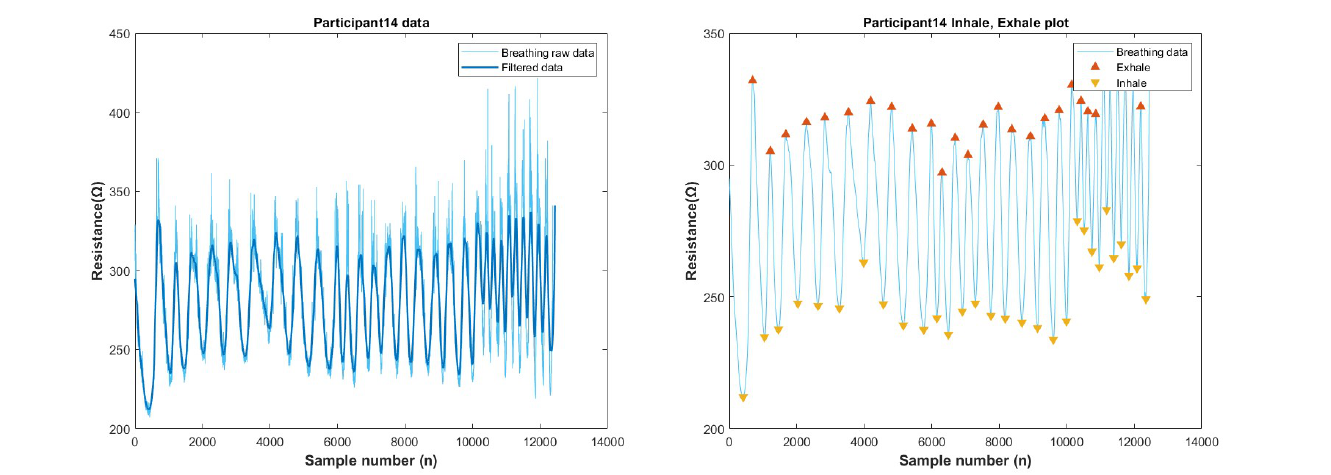
Figure A29. Breathing Test data of Participant number-14.